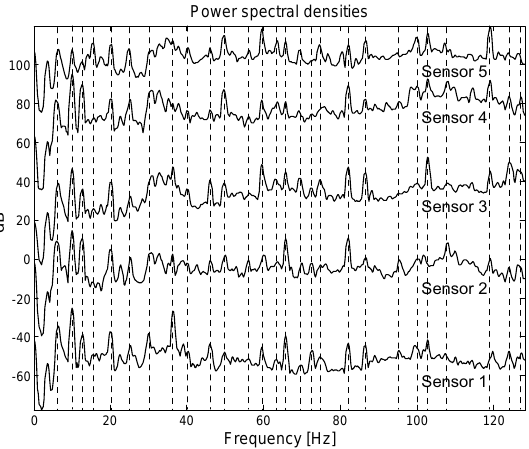
Fig. 11. Power spectral densities computed at different sensors. The spectra have been purposely shifted along the vertical axis for better visualisation. Vertical dotted lines indicate the peaks of greatest power.